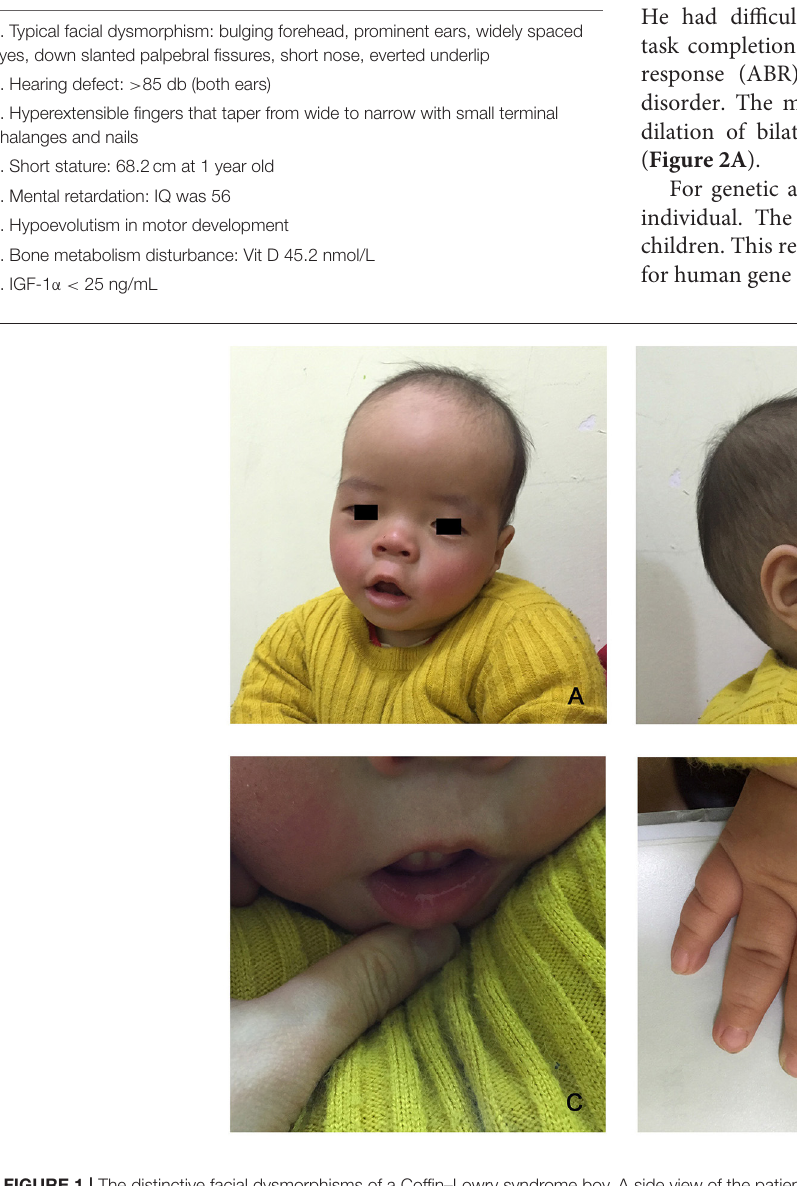
FIGURE 1 | The distinctive facial dysmorphisms of a Coffin–Lowry syndrome boy. A side view of the patient’s face (B) , prominent ears, widely spaced eyes, down slanted palpebral fissures, short nose with broad columella, thick alae nasi and septum, thick and everted underlip (A,C) . (D) The hands are short and with puffy tapered finger, small terminal phalanges, and